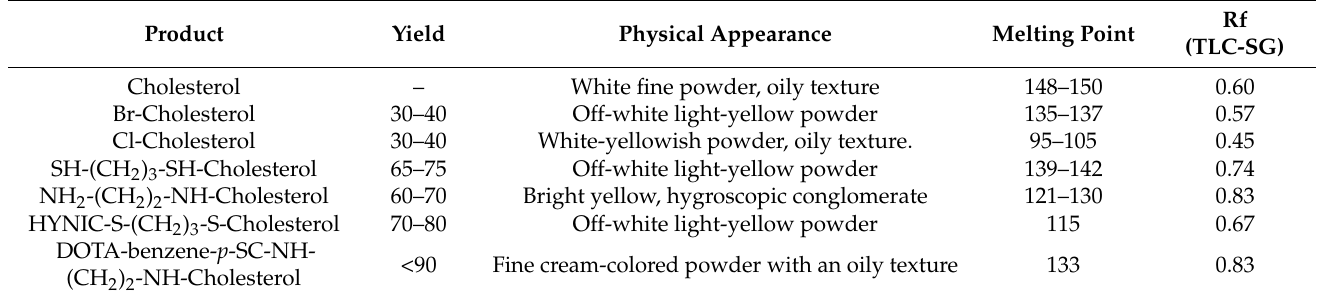
Table 1. Physicochemical properties of cholesterol